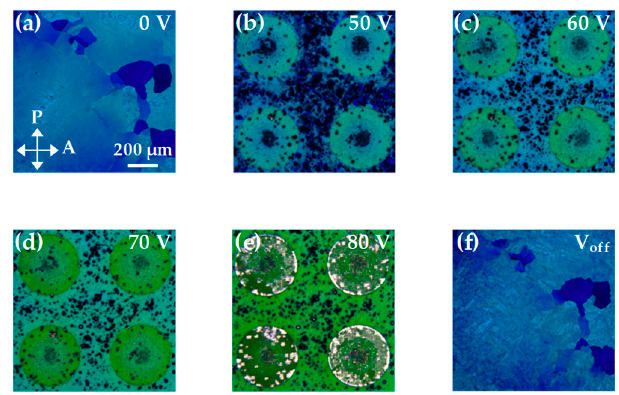
Figure 4. Microscopic images of the BPLC microlens array, which was placed between crossed polarizers, with the applied voltages of ( a ) 0 V; ( b ) 50 V; ( c ) 60 V; ( d ) 70 V; ( e ) 80 V; and ( f ) 0 V, respectively. The temperature was fixed at 38.5 °C.